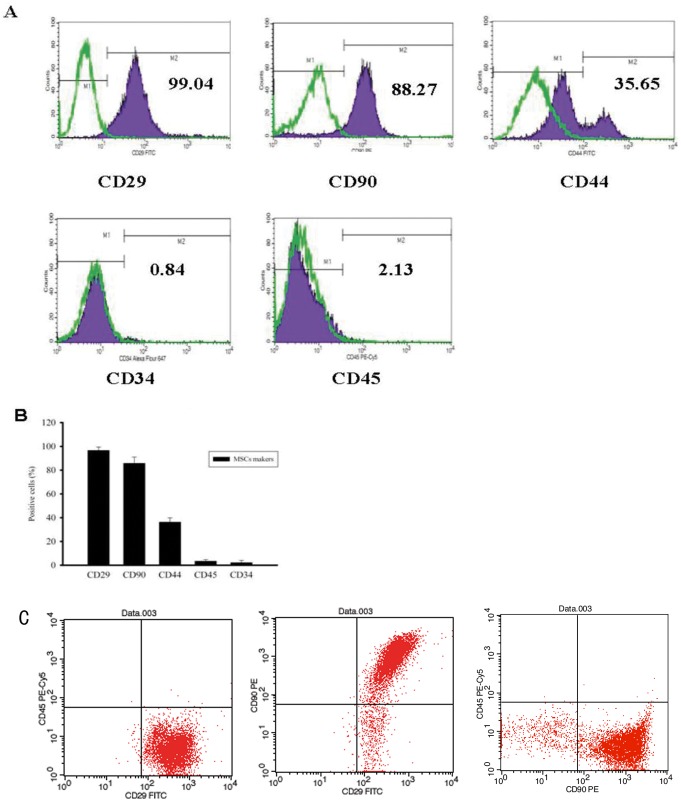
Cell surface markers of MSCs.The surface marker molecules expressed by the Passage 5 culture of MSCs were analyzed by flow cytometry. (B) Quantification by image analysis of the positive cells. The numbers in the histograms indicate the mean fluorescence of each MSC markers. (C) Percent of MSCs obtained from culturing bone marrow cells.